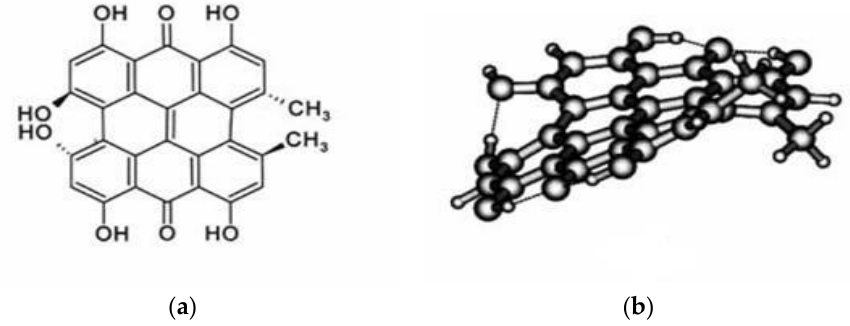
Figure 2. Two-dimensional ( a ) and three-dimensional ( b ) structure of hypericin [97].